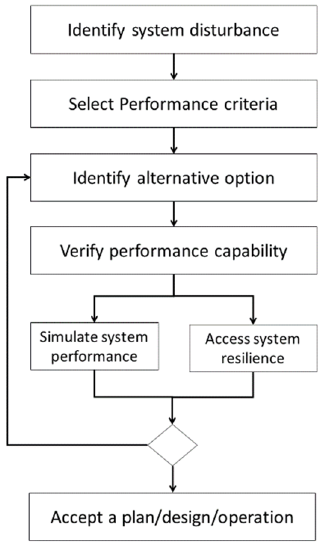
Figure 2. Performance-based engineering process.